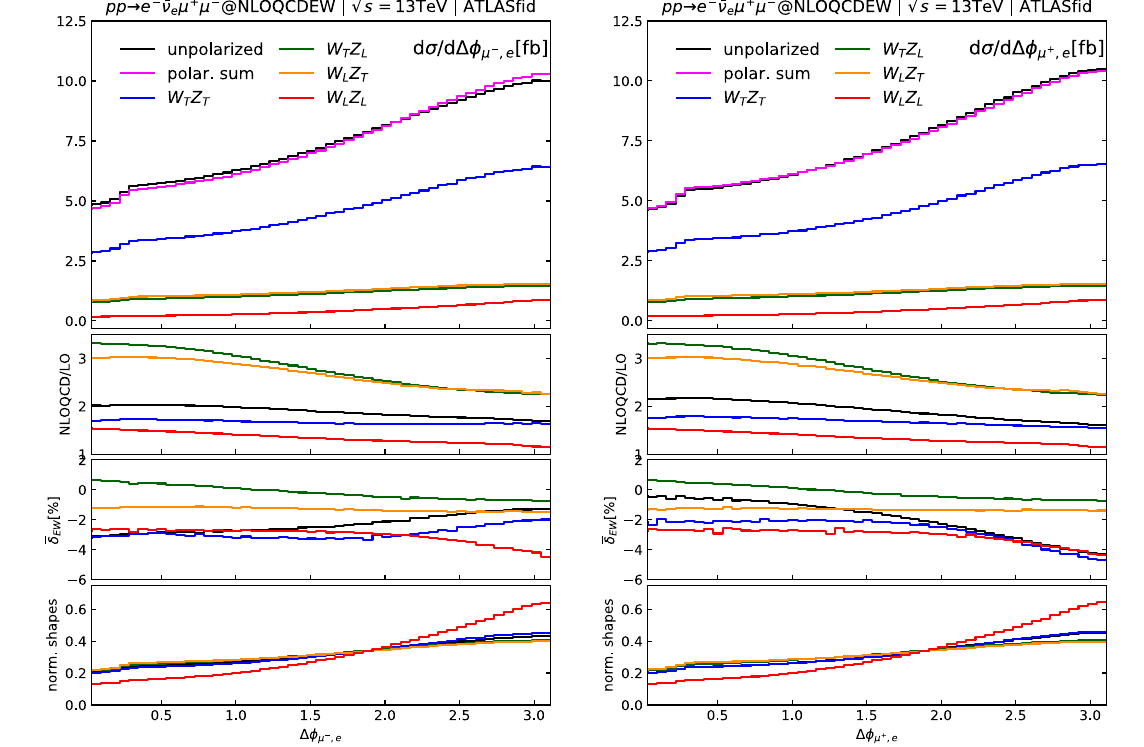
Fig. 3 Same as Fig. 2 but for the azimuthal separation between the electron and the muon (cid:13)φ μ − , e − (left) and between the electron and the anti-muon (cid:13)φ